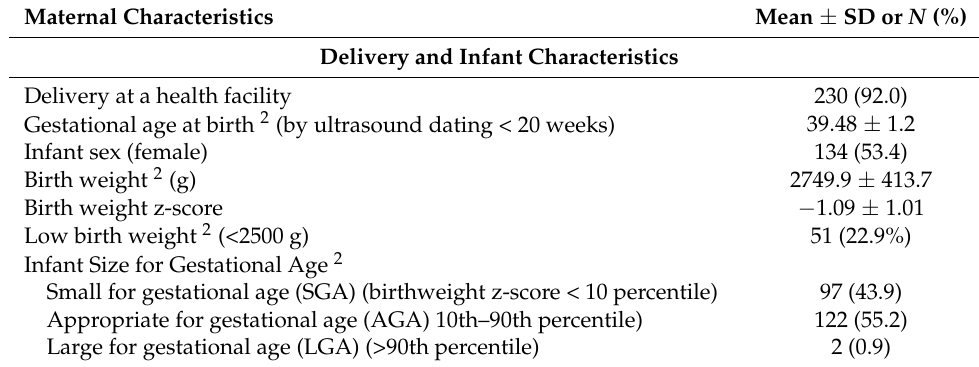
( b ) Figure 1. Estimated average weekly consumption (grams) of food items through the course of ges- tation among ( n = 251) pregnant women in Sylhet, Bangladesh: ( a ) animal source and ( b ) plant-based food items. Table 2 shows the estimated nutrient intake of pregnant women in this population for 20 nutrients as determined from FFQ responses, compared to Institute of Medicine (IOM) recommended values in pregnancy [46]. Nutrient intake in this population was substantially lower than recommended intake in pregnancy for most nutrients [46], with the exception of Vitamin C. Figure 2 shows a correlation matrix of nutrient intake. The intakes of several vitamins were highly correlated (r > 0.80). Daily intake of most B vita- mins (B3, B6 and B9) were highly correlated with each other, with relatively lower corre- lation with B12 intake. Vitamin B3, B6 and B9 intake was also strongly correlated with Vitamin D, Vitamin E, iron, and zinc intake. Correlation among the different LCPUFAs were also high. Table 2. Daily nutrient intake during Pregnancy in Projahnmo Cohort, Sylhet, Bangladesh ( n = 244). Nutrient